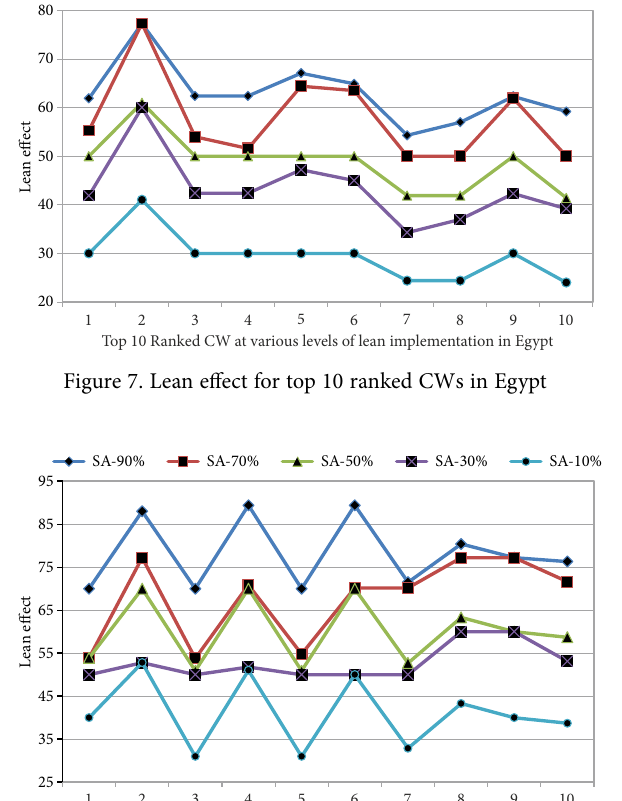
KSA1 Top 10 Ranked CW at various levels of lean implementation in Figure 8. Lean effect for top 10 ranked CWs in KSA